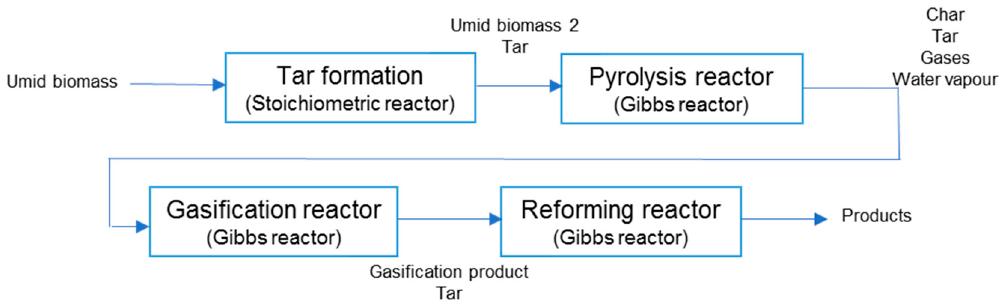
Figure 2. Flow chart of the ChemCad model of the gasifier.